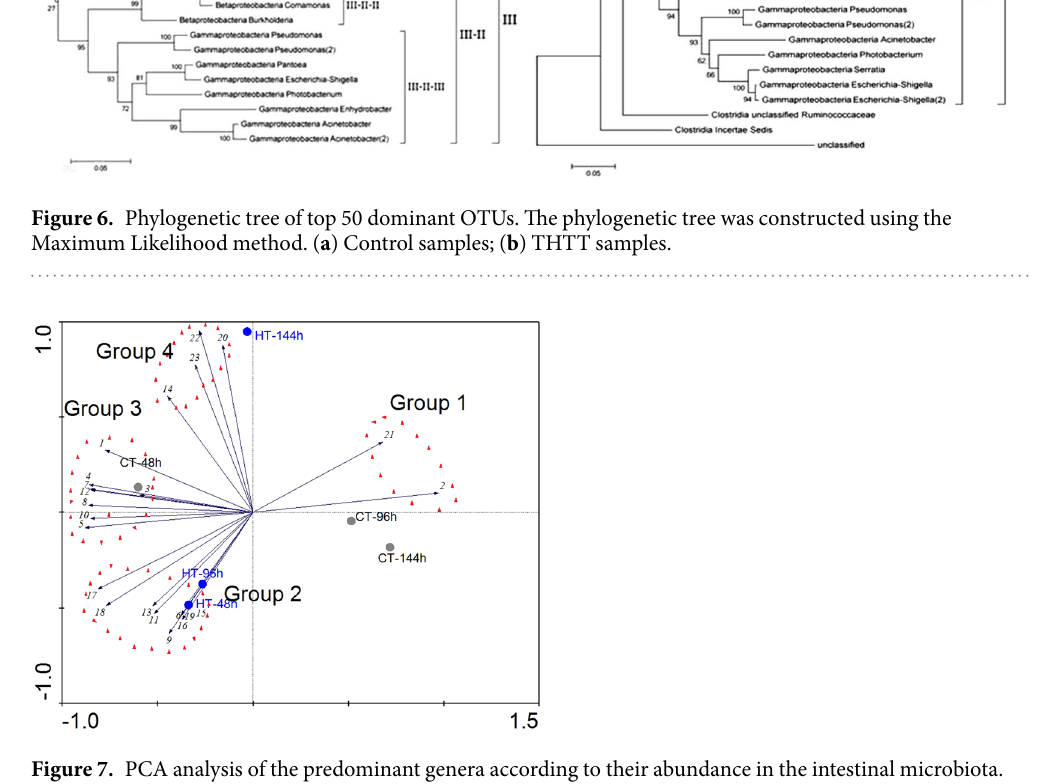
Figure 7. PCA analysis of the predominant genera according to their abundance in the intestinal microbiota. 1–23 represent dominant genera mentioned in Table